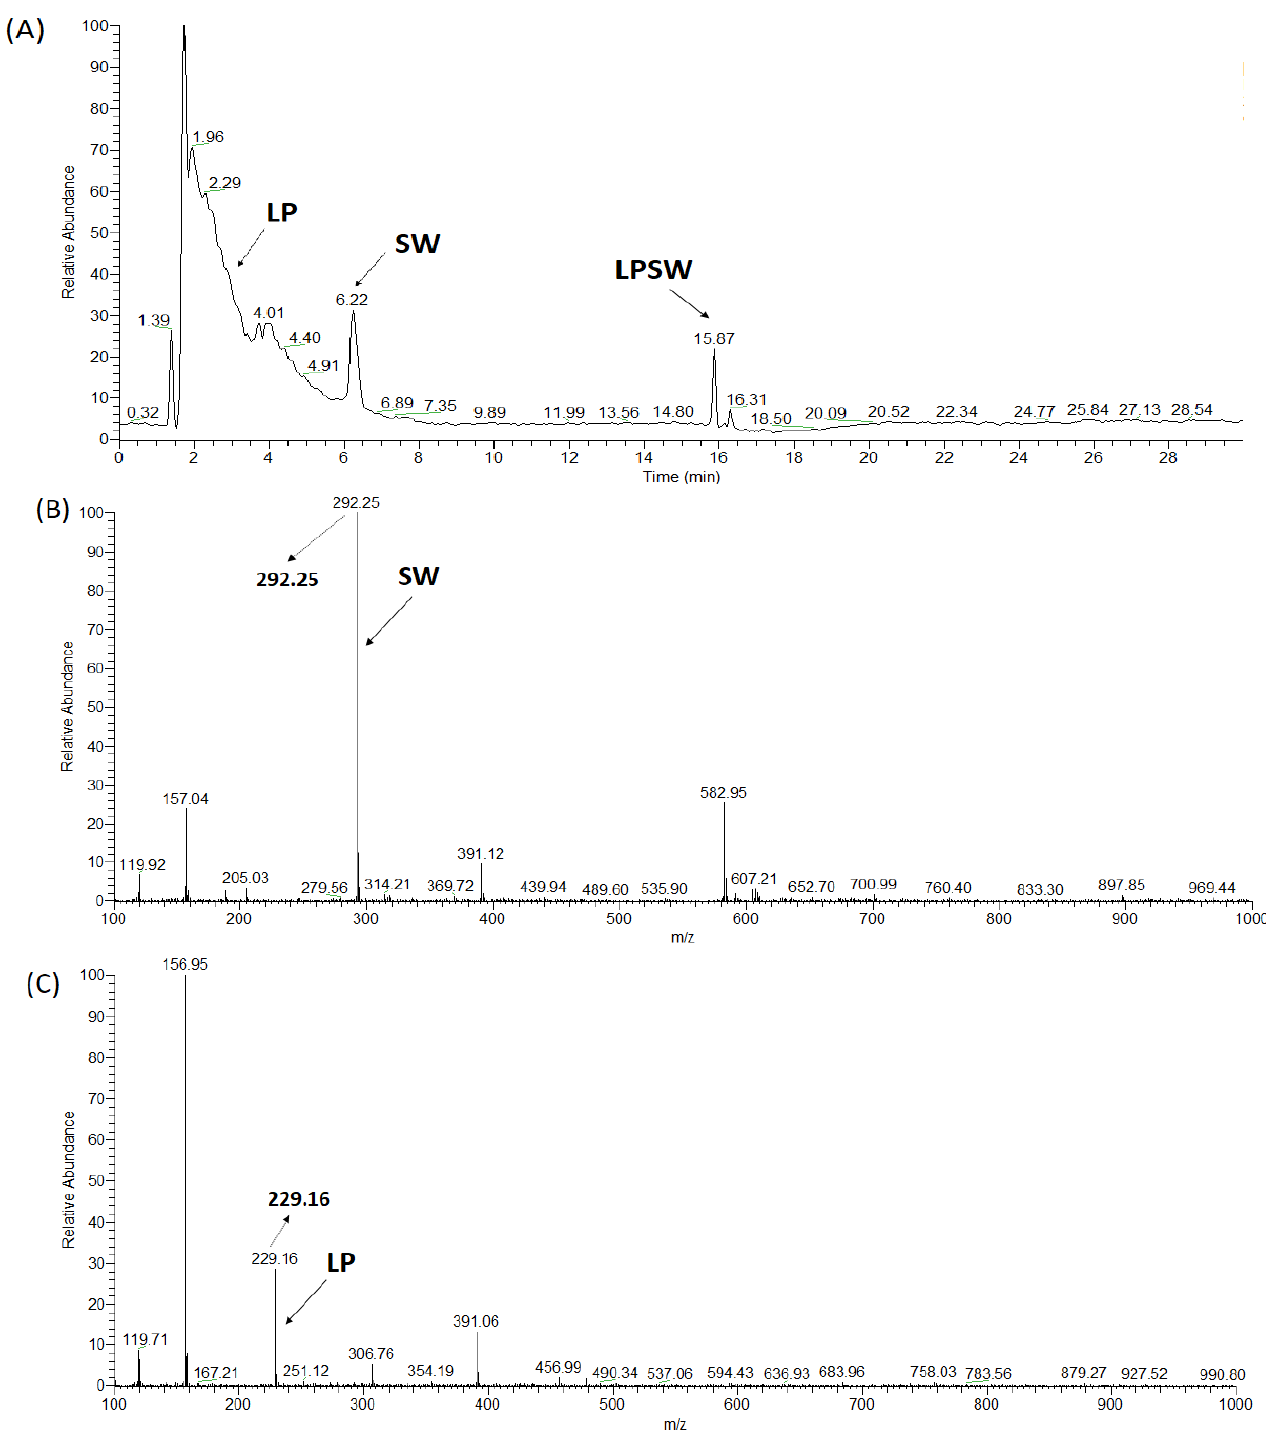
Figure 2. Liquid chromatography–mass spectrometry (LC-MS) profile of ( A ) LPSW full scan (m/z 502), ( B ) SW fragment (m/z 292.25), and ( C ) LP fragment (m/z 229.24) derived from LPSW preincu- bated with ACE for 3 h at 37 °C.